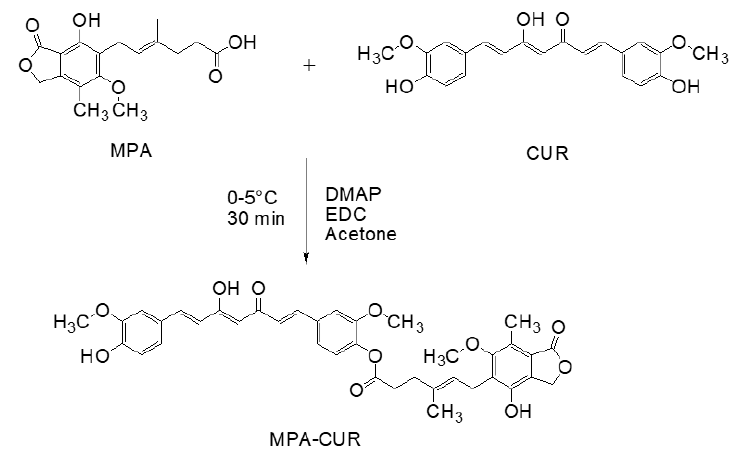
Figure 2. Synthesis of the MPA-CUR